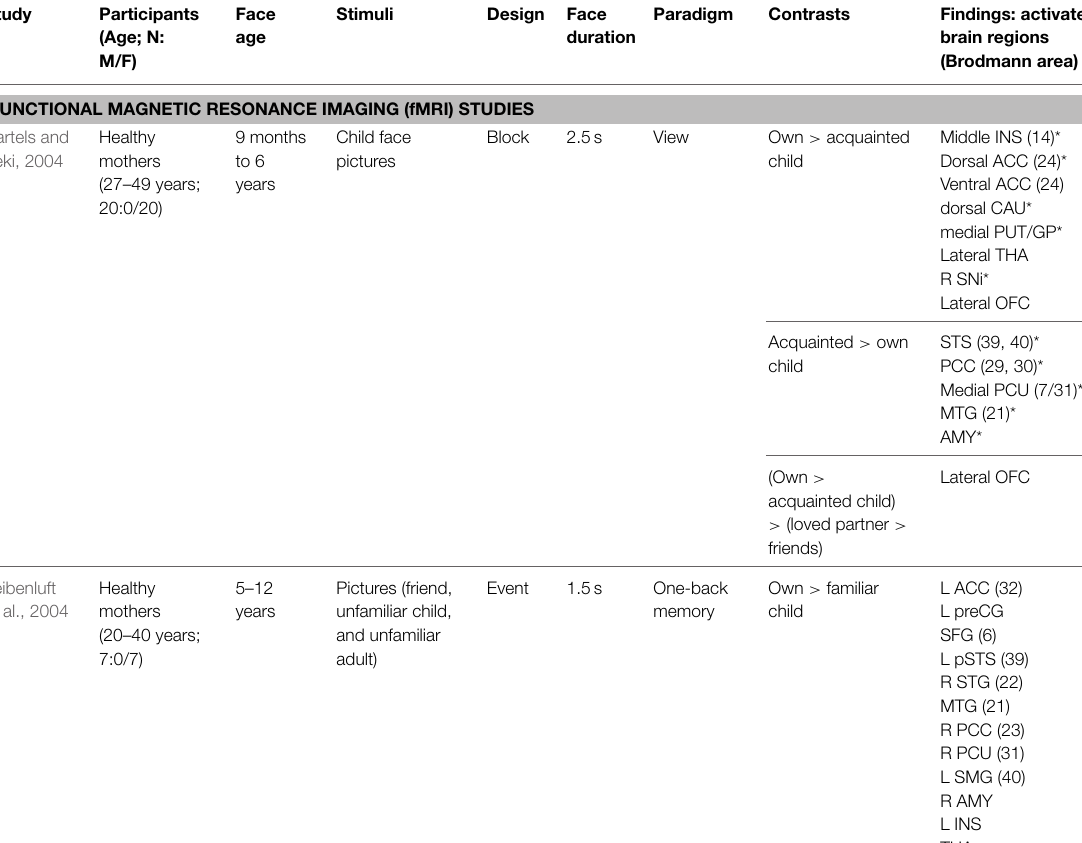
TABLE 1 | Neural responses to infant and child faces.